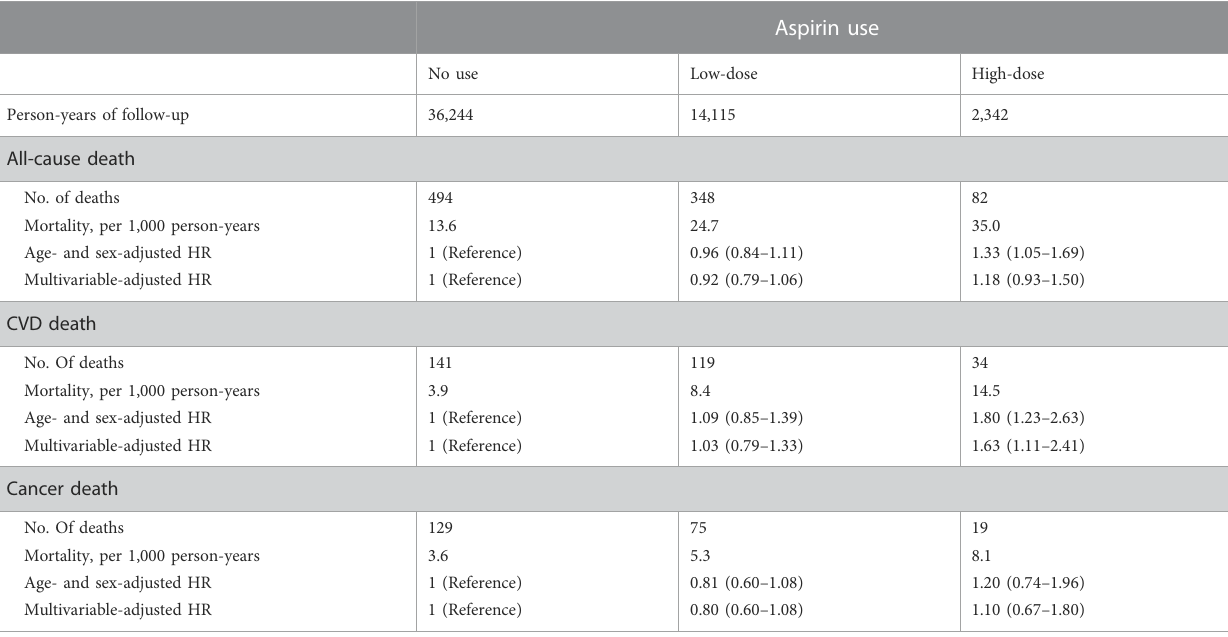
TABLE 2 Multivariable-adjusted hazard ratio (HR) and 95% con fi dence interval (CI) of aspirin use associated with deaths from all-cause, cardiovascular disease (CVD), and